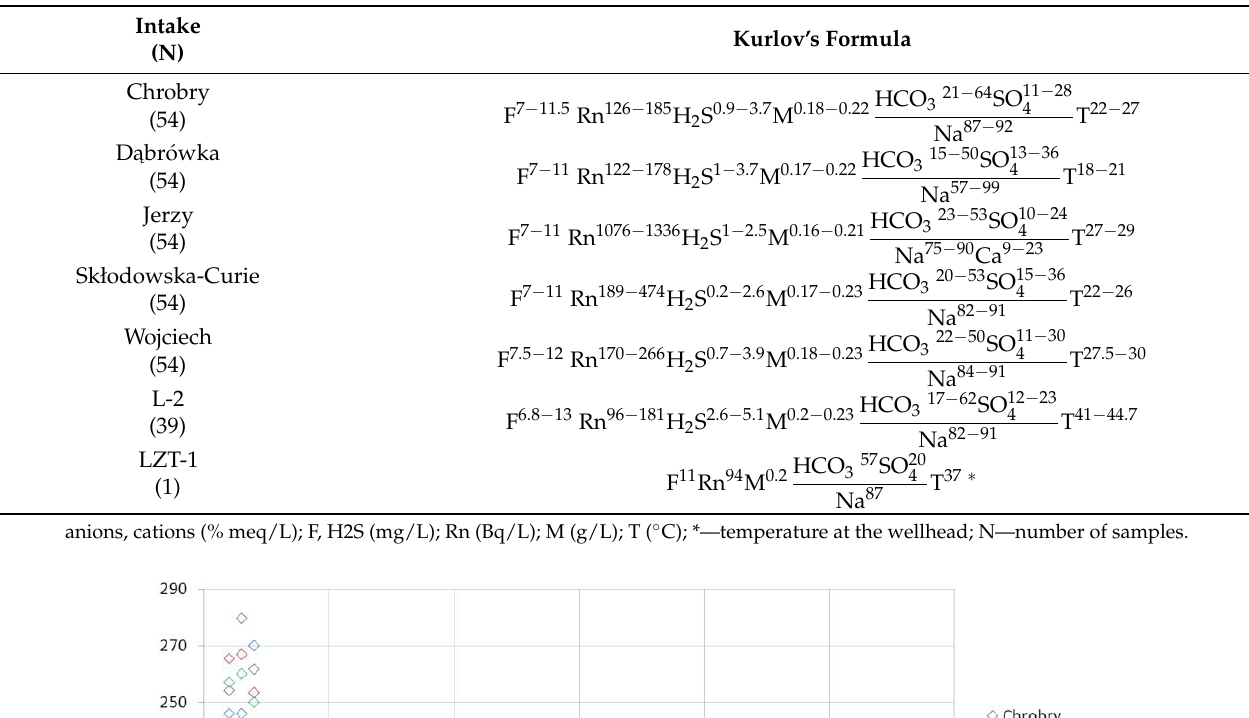
Table 5. Minimum and maximum concentrations of major ions and specific components (in years 1965–2016) expressed by a simplified version of Kurlov’s formula and the volume of exploitable water resources (based on [65,72,79]).